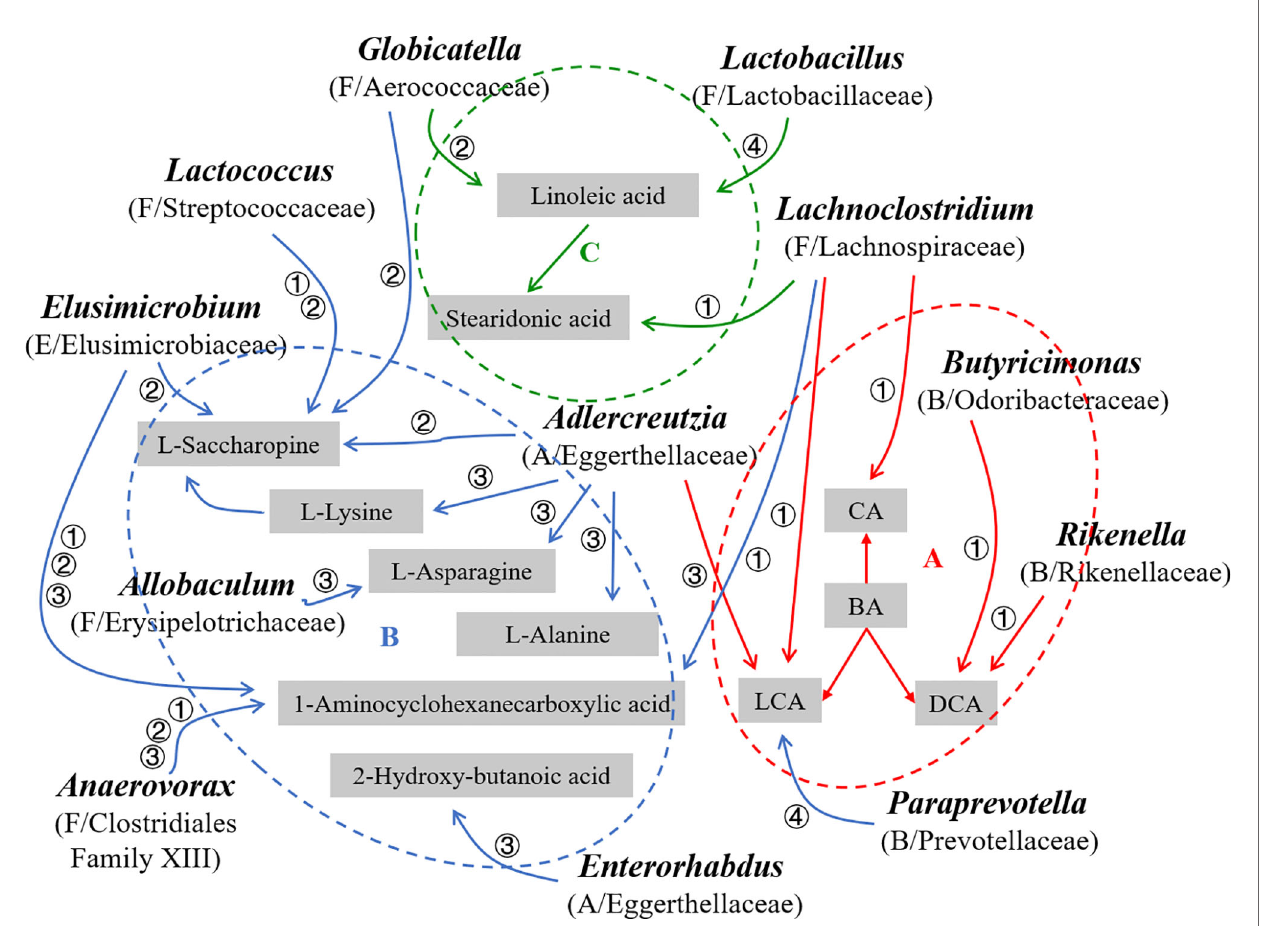
FIGURE 11 | Schematic diagram of the GM and key metabolites probably associated with PMOP development and (or) improvement in OVX rats (n = 10). The red ( ! , A, ⚬ ), blue ( ! , B, ⚬ ) and green ( ! , C, ⚬ ) information represent bile acid, amino acid and fatty acid metabolisms, respectively. A, Actinobacteria; B, Bacteroidetes; F, Firmicutes; E. Elusimicrobia; BA, Bile acid, CA, Cholic acid, LCA, Lithocholic acid, DCA, Deoxycholic acid; ① , ② , ③ and ④ mean Sham vs OVX, OVX+ICA vs OVX, OVX+E2 vs OVX and OVX+ICA vs OVX+E2,